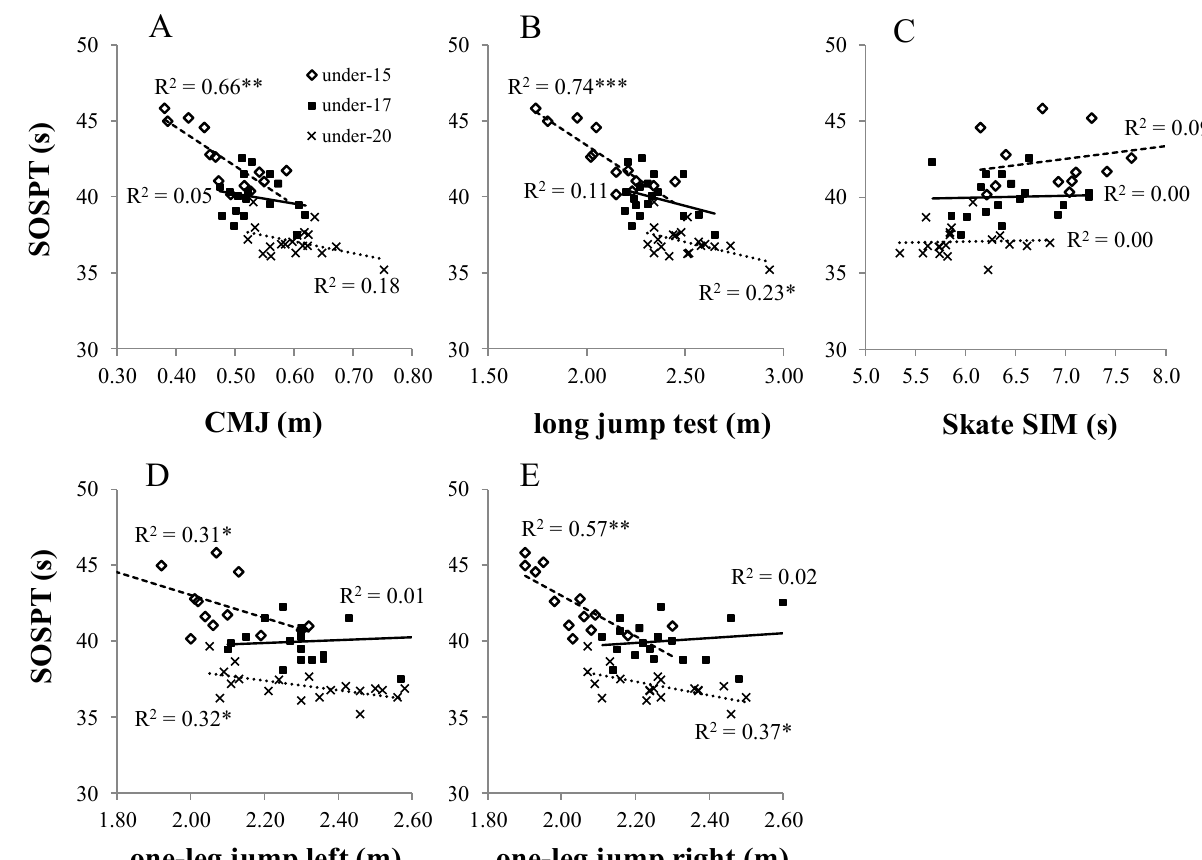
Figure 2. Linear regression analysis scatter-plot of the specific overall skating performance test (SOSPT) and ( A ) countermovement jump height (CMJ), ( B ) standing long jump distance (long jump test), ( C ) total time on the lateral skate simulation test (Skate SIM), ( D ) lateral single-leg jump left leg, and ( E ) lateral single-leg jump right leg separated by age groups into under-20, under-17, and under-15 players. ( p < 0.001 ***; p < 0.01 **; p < 0.05 *).